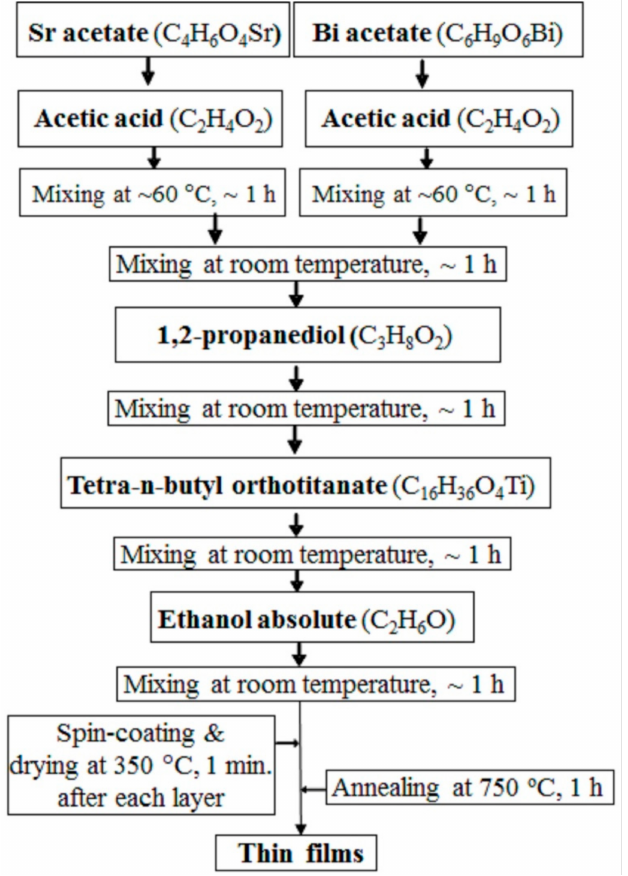
Figure 1. Schematic diagram of the preparation process for Sr 1 − 1.5x Bi x TiO 3 thin films with x = 0.0053 and 0.167 deposited on Al 2 O 3